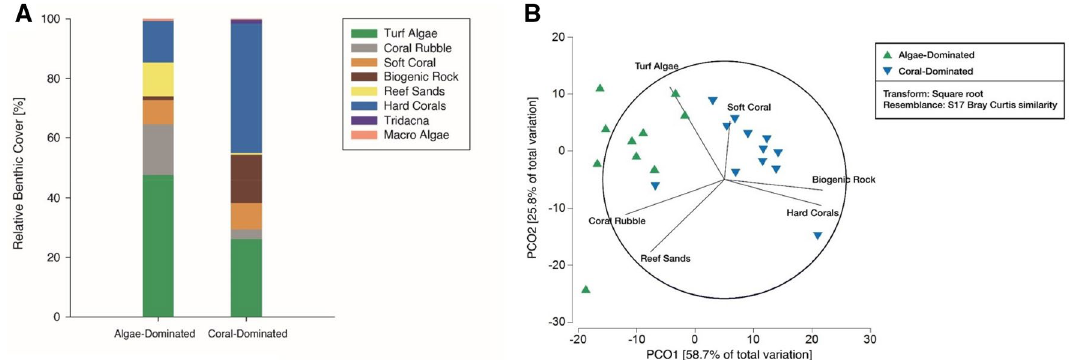
Figure 1. ( A ) Relative benthic cover in algae- and coral-dominated areas. Benthic cover is presented as mean proportional cover of major benthic categories assessed by photo quadrats (n = 10 in algae-dominated areas, n = 12 in coral-dominated areas). Adapted from Roth et. al 51 . ( B ) Principle Coordinate Analysis (PCO) of benthic community cover at the algae-dominated (green) and coral-dominated (blue) areas. Vector overlays shows correlations > 0.4 based on Pearson ranking, green triangles display replicates of algae-dominated areas (n = 10), blue triangles display replicates of coral-dominated areas (n =